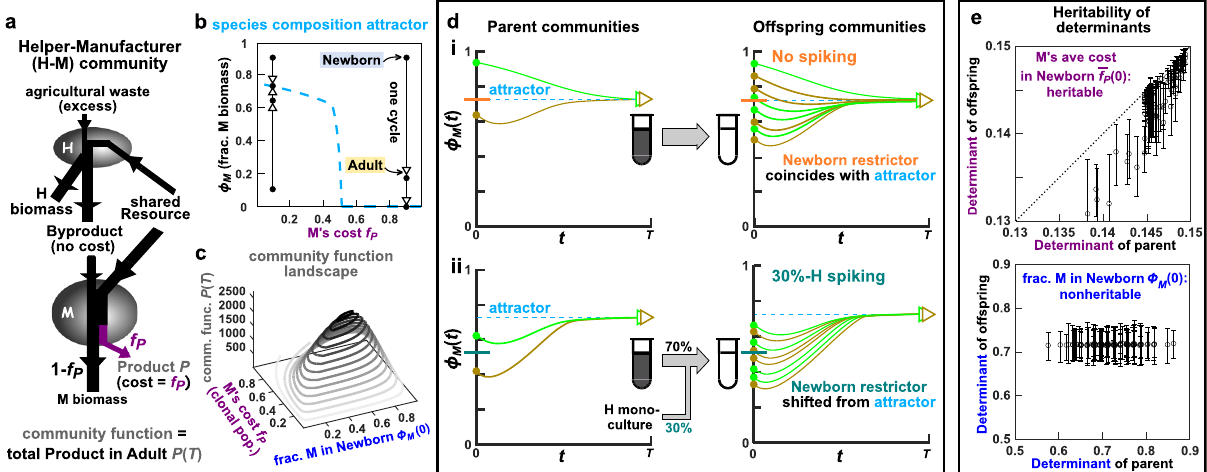
Fig. 2 A two-species commensal community, its species-composition attractor and restrictor, and its community function landscape in relation to heritable and nonheritable determinants. a The Helper – Manufacturer commensal community. b Species-composition attractor. Each arrow describes the change in ϕ M , the fraction of M ’ s biomass in a community, from Newborn to Adult over one maturation cycle. All arrows are “ attracted ” to the species-composition attractor (blue dashed curve). Depending on whether M ’ s cost f P is high or low, M goes extinct or coexists with H, respectively. c Community function landscape for clonal H and M populations. ( b ) and ( c ) are calculated by numerically integrating Equations (1 – 7) with Newborn ’ s total biomass = 100, maturation time T = 17, and all M cells having the same cost f P . Note that community function is de fi ned for Adults, since Newborns have zero Product. Newborn (but not Adult) species composition is a community function determinant, since at a fi xed cost f P , different Newborn species compositions lead to the same Adult species composition ( b ) yet different community functions ( c ). d Newborn composition restrictor ( “ restrictor ” ) coincides with the attractor, unless experimentally manipulated. ( i ) Two parent Newborns mature into parent Adults whose species compositions reach the same attractor. When these two Adults reproduce via pipetting, species compositions of offspring Newborns (green and mustard dots) fl uctuate around the attractor. Therefore, the Newborn restrictor (orange) coincides with the attractor (blue). ( ii ) When 70% of Newborn biomass comes from the parent Adult and the other 30% comes from H (30%-H spiking), the Newborn restrictor (teal line) is shifted down from the attractor by about 30%. Note that the effect of spiking on species composition is erased over one cycle — Adult species compositions reach the attractor regardless of spiking. e Newborn average cost f P ð 0 Þ is largely heritable (positive slope), while Newborn species composition ϕ M (0) is not heritable (zero slope). Individual-based stochastic simulations were carried out over one selection cycle (Methods), and M ’ s cost f P can mutate. Each circle is obtained by plotting the mean determinant of ~60 offspring Newborns against the determinant of their parent Newborn. The corresponding error bars extend from 25% to 75% quantile (see Supplementary Fig. 4 for statistical distributions of the two determinants).